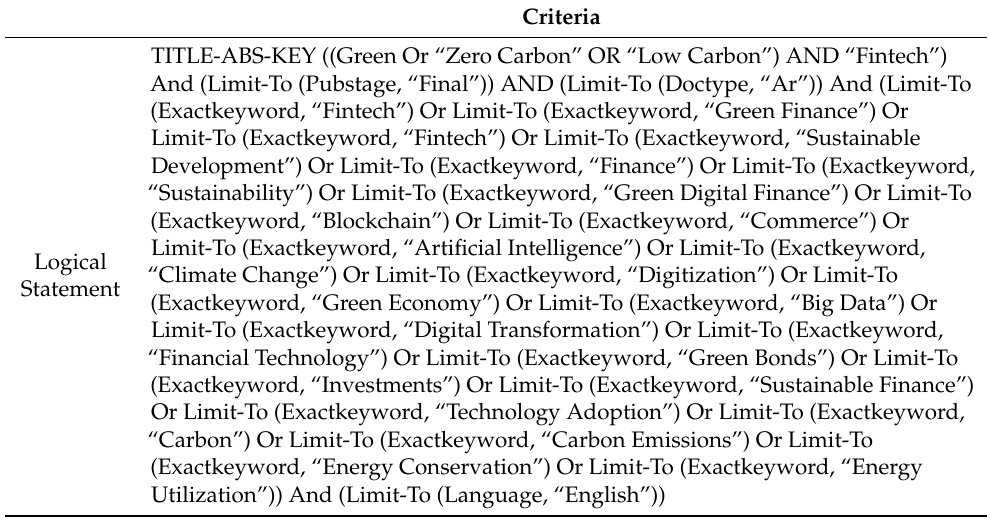
Table 1. Inclusion and exclusion criteria for the systematic-cum-bibliometric